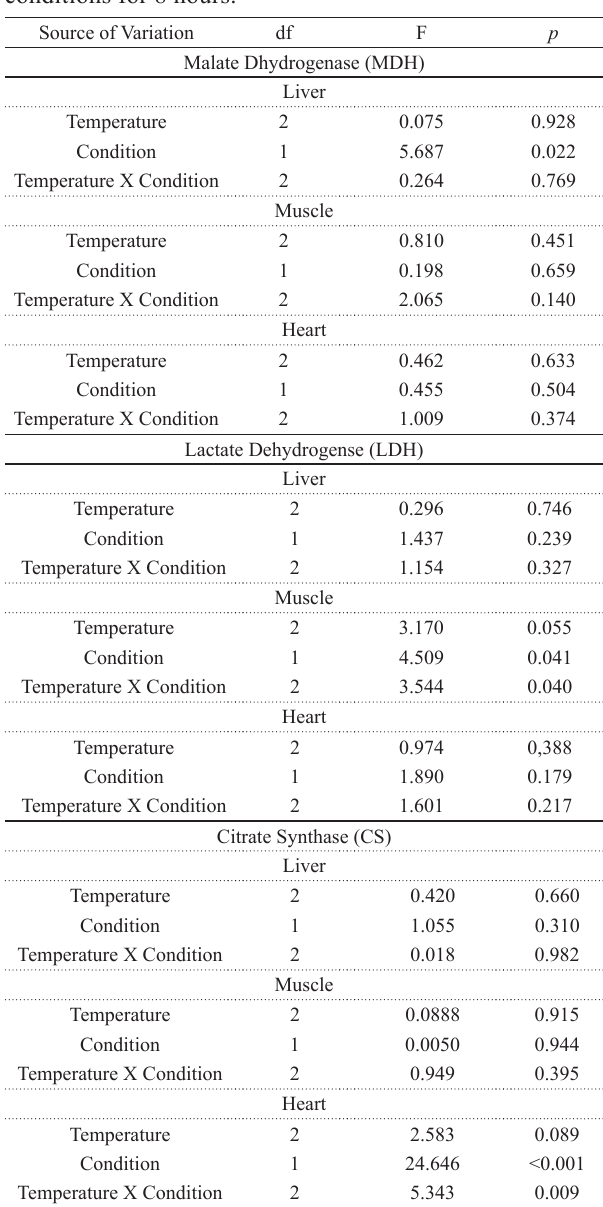
Tab. 2. Two-way ANOVA of Malate Dehydrogenase (MDH), Lactate Dehydrogenase (LDH) and Cytrate